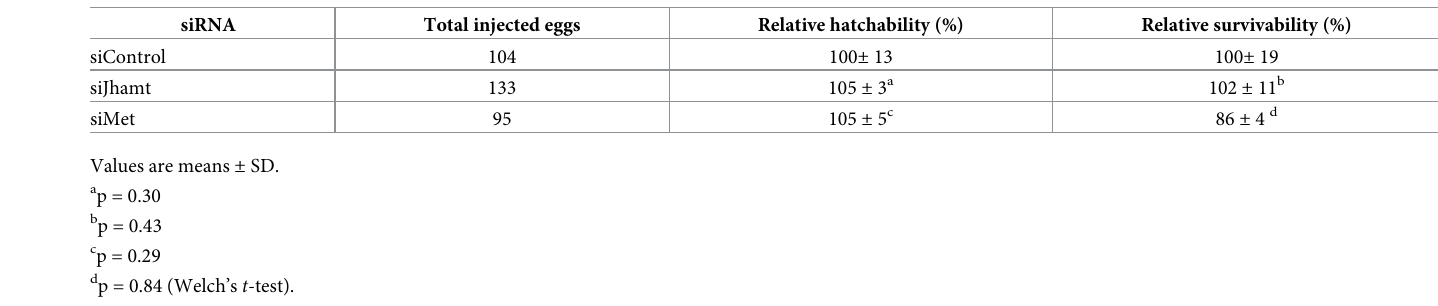
Table 1. RNAi inhibition of sesquiterpenoid pathway